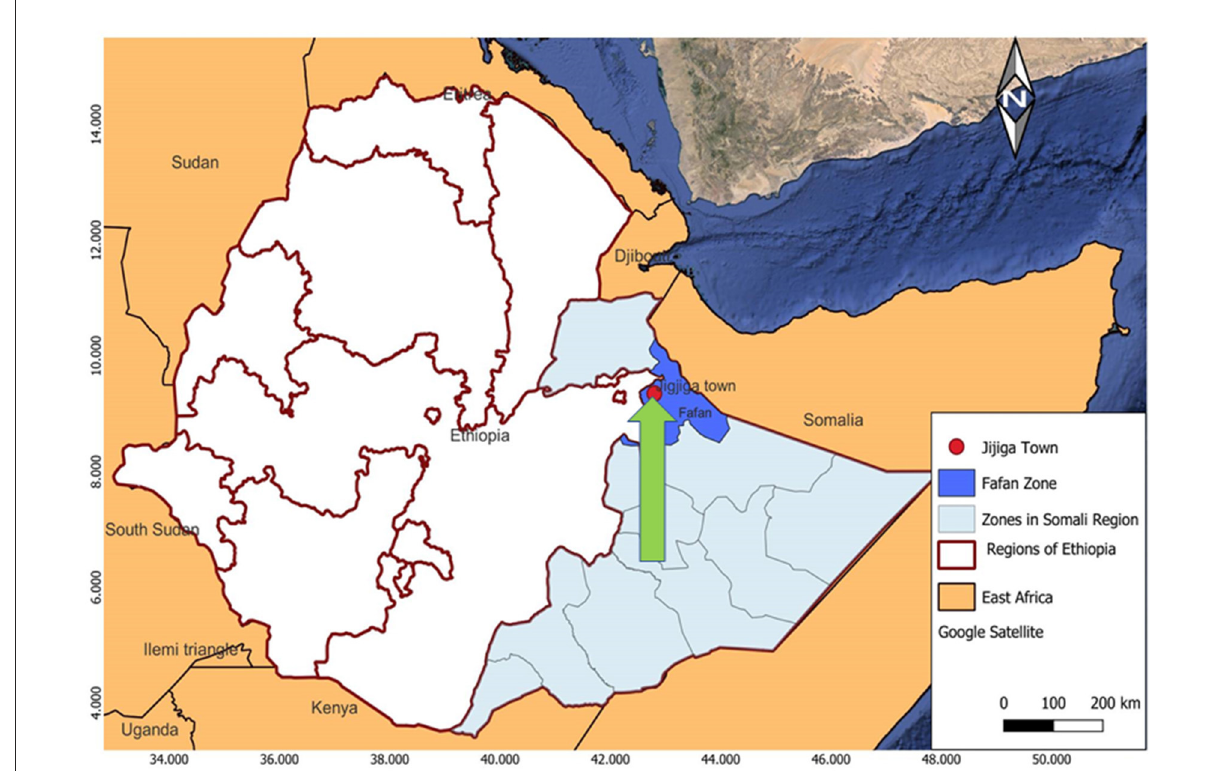
FIGURE1 Map of the study area. The arrow indicates the City of Jigjiga that is indicated with a red filled circle. The patients were recruited from three health care provider clinics and hospitals, which are located in the Jigjiga City, namely the Abilelie Health center, Karamara Regional hospital, and Jigjiga University Sheik Hassan Yabare Referral